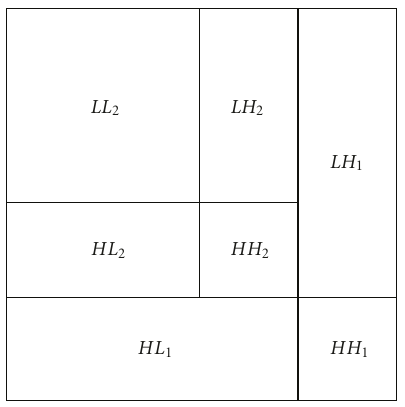
Figure 9: Second Level FHT Decomposition.